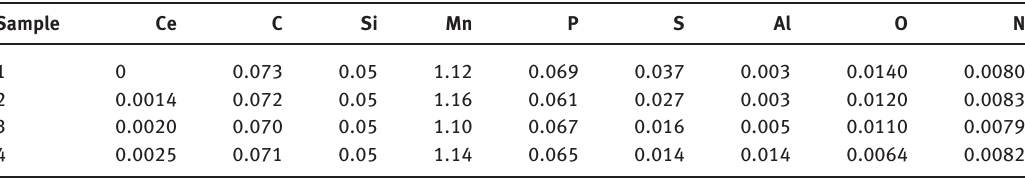
Table 1: Chemical compositions of experimental steels (mass%). Sample